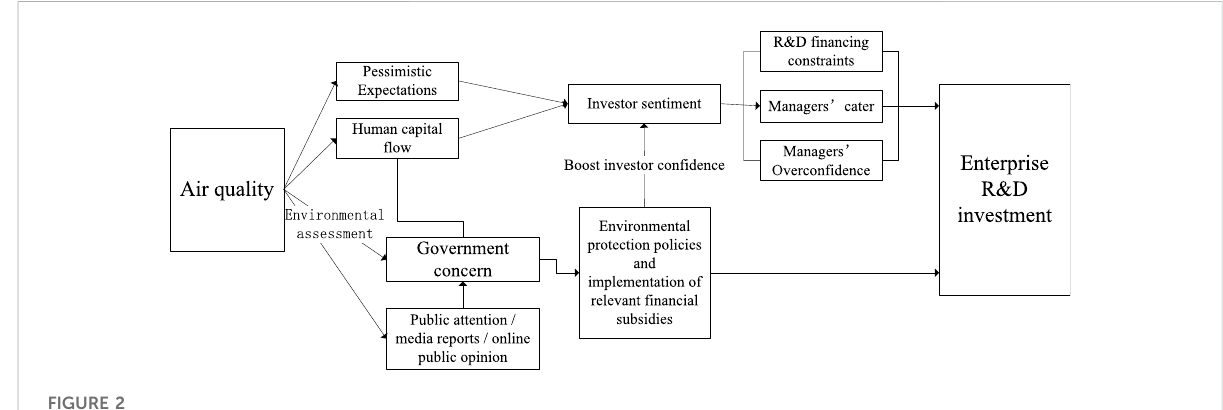
FIGURE 2 The mechanism of air pollution affecting enterprise R&D investment